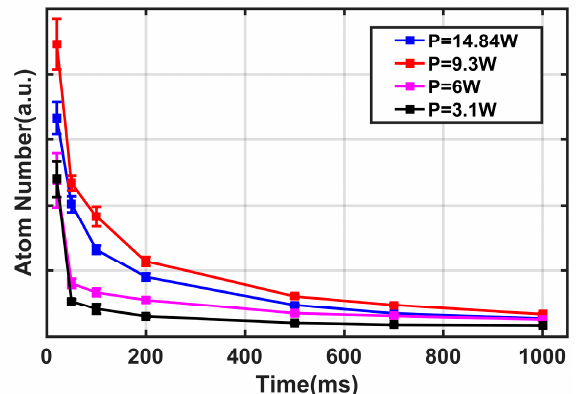
Figure 3. Dependence of number of guided atoms on time at different laser powers. Error bars on selected experimental points are representative of the standard error associated with our analysis method.